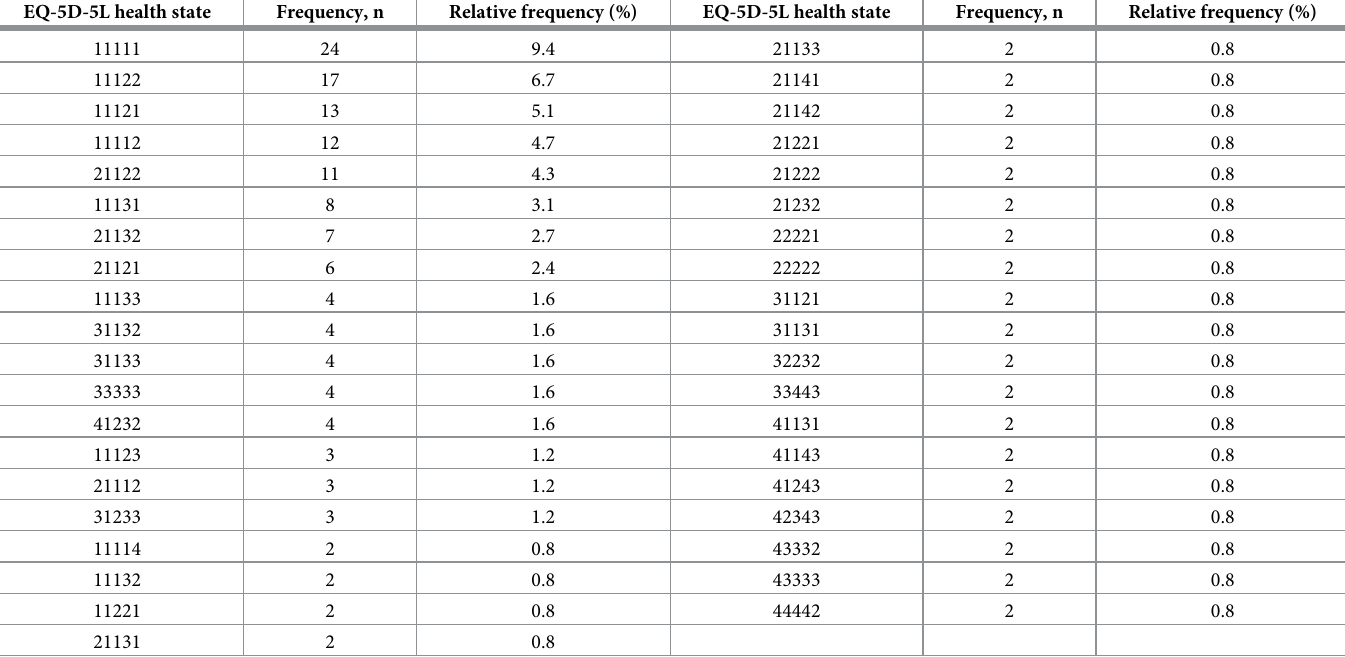
Table 3. Diabetes patients’ health status according to EQ-5D-5L (N =